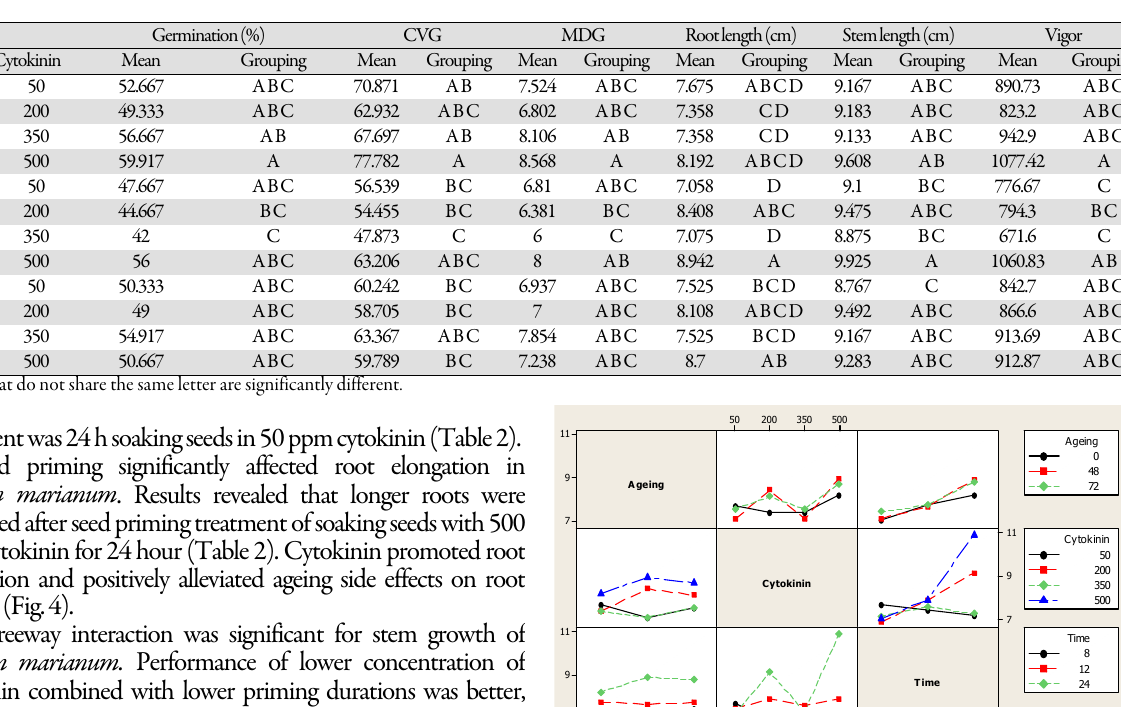
Table 3. Mean comparison of ageing duration and cytokinin concentrations on germination properties of Silybum marianum